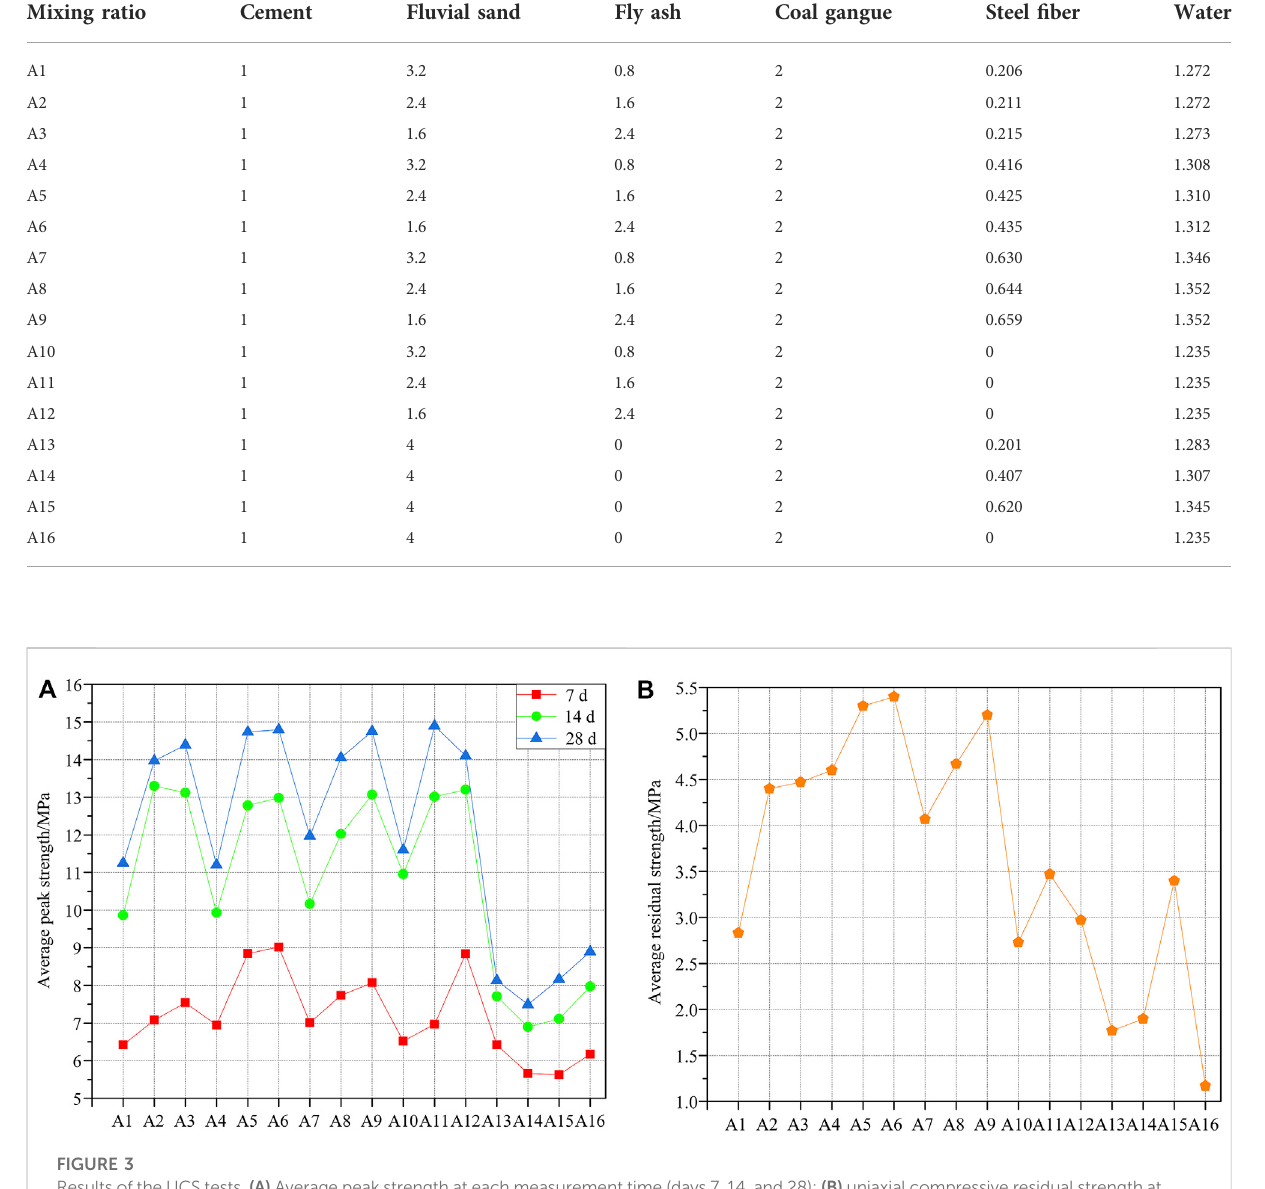
TABLE 1 Details of the 16 mixing ratios used in this study.